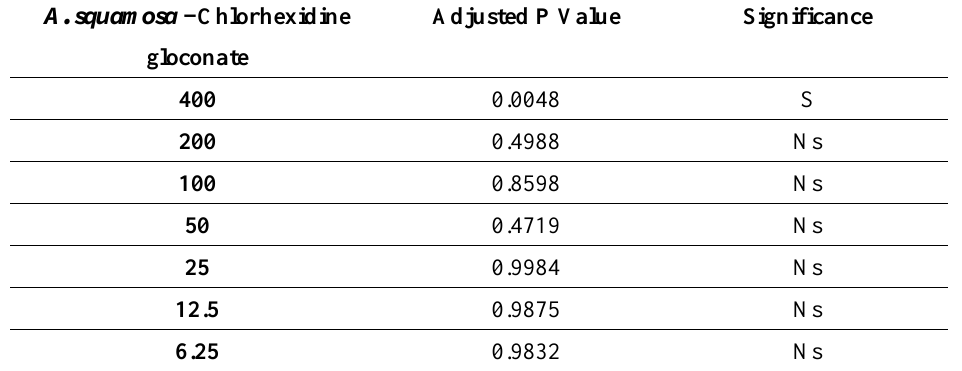
Table 3: Independent samples t-test to compare the significance of differences in cells viability mean values between the Annona squamosa in comparison to Chlorhexidine gloconate